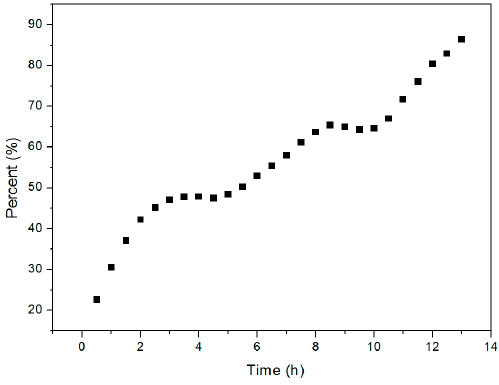
Figure 7. Percentage of Cu 2 O solid solution formed as a function of reaction time.